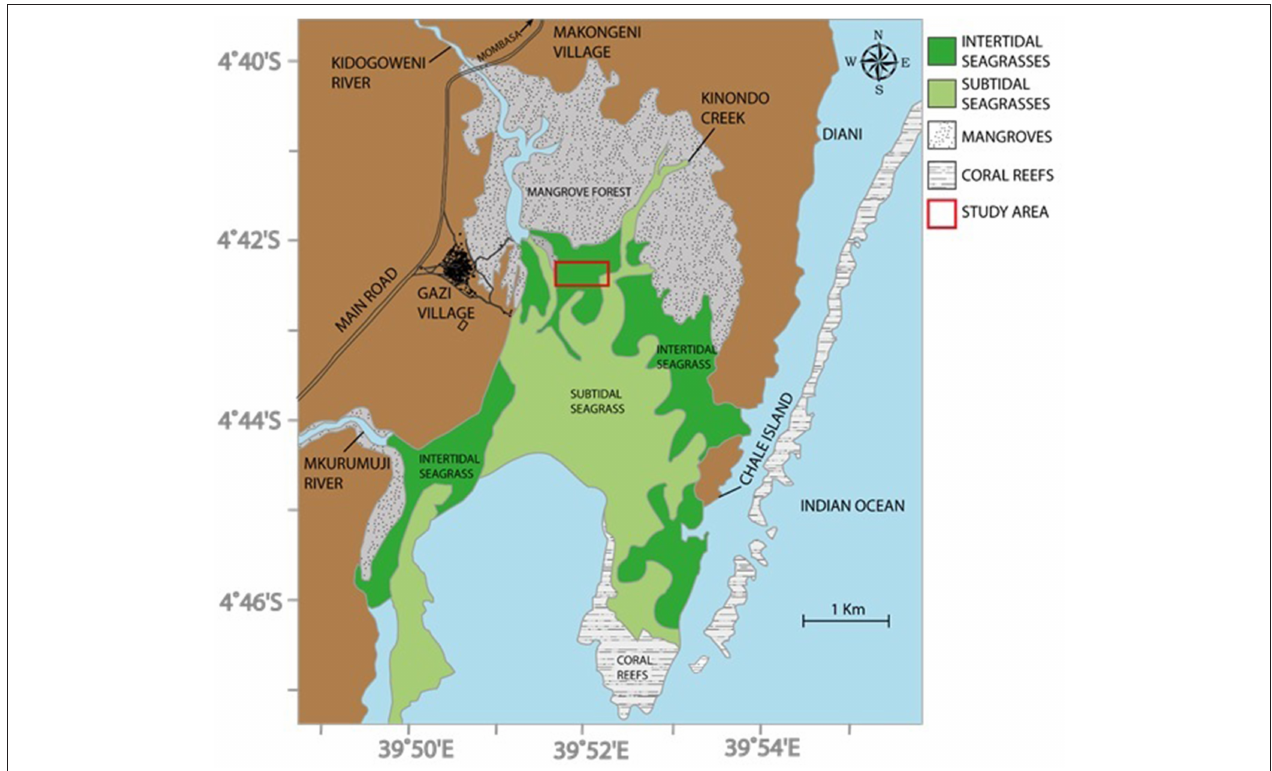
FIGURE 1 | Seagrass experimental area, Gazi Bay, Kenya (after Troch et al., 2001; Bouillon et al.,